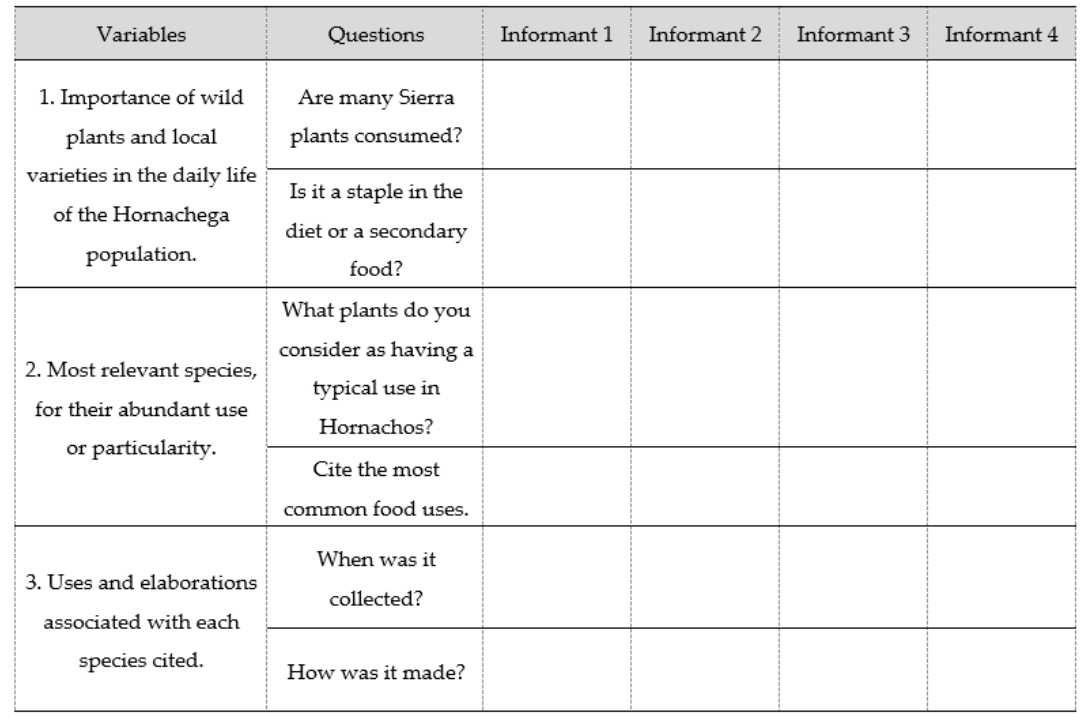
Figure 4. Spreadsheet model to enter the data extracted from interviews.